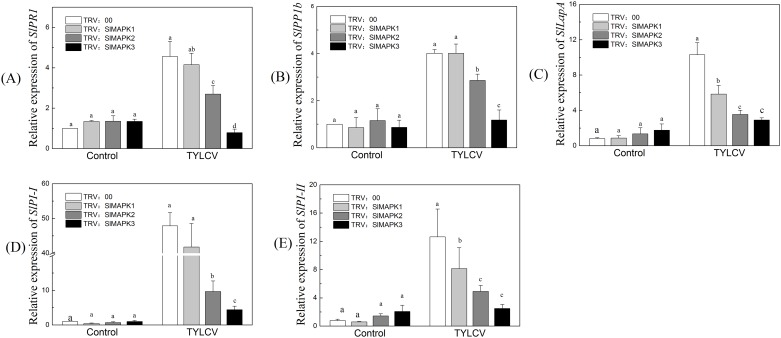
Defense-related gene expression decreased when SlMAPK1, SlMAPK2, SlMAPK3-silenced ‘Y19’ tomato plants were infected with TYLCV.(A-E) The relative expression of the SA-mediated defense marker genes SlPR1 (A), SlPR1b (B) and the JA-mediated defense marker genes SlLapA (C), SlPI-I (D) and SlPI-II (E) at 14 dpi with TYLCV. Values are means ± standard error (SE), replicated thrice. The treatments were compared with the control using Tukey’s test. Different letters indicate significant differences at P<0.05.